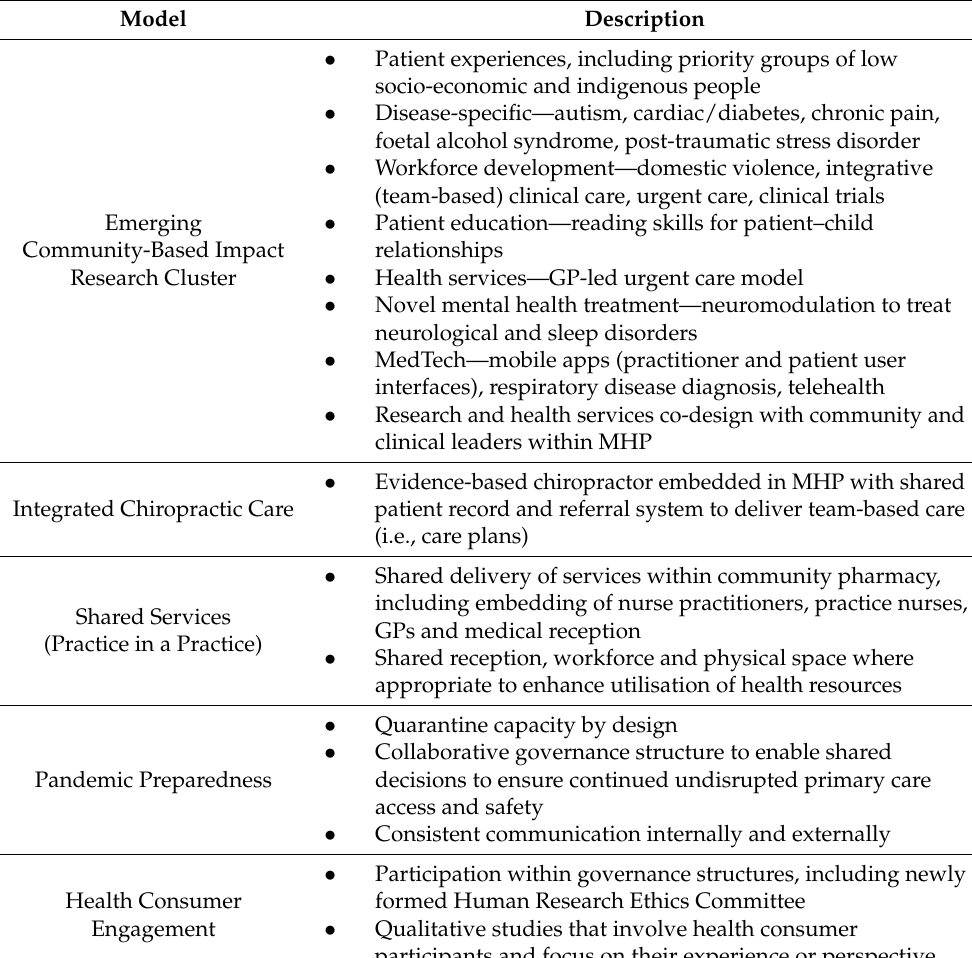
Table 2. Novel models within Morayfield Health Precinct